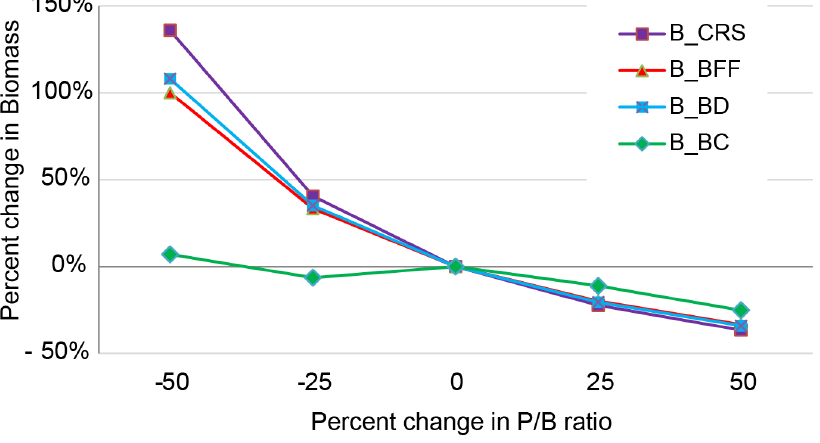
Figure 2. Results of sensitivity analysis of four invertebrate groups to changing the P/B ratio on the biomass.